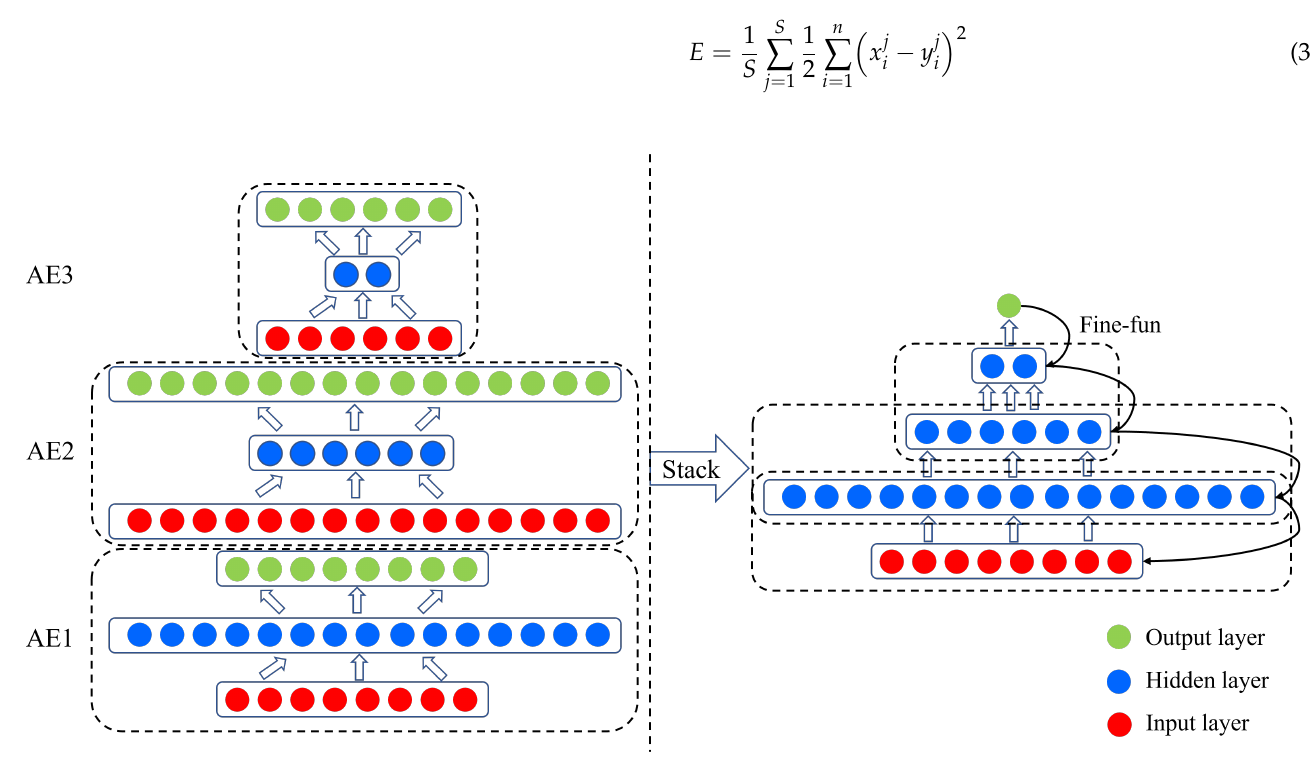
Figure 2. The structure of a stacked autoencoder.